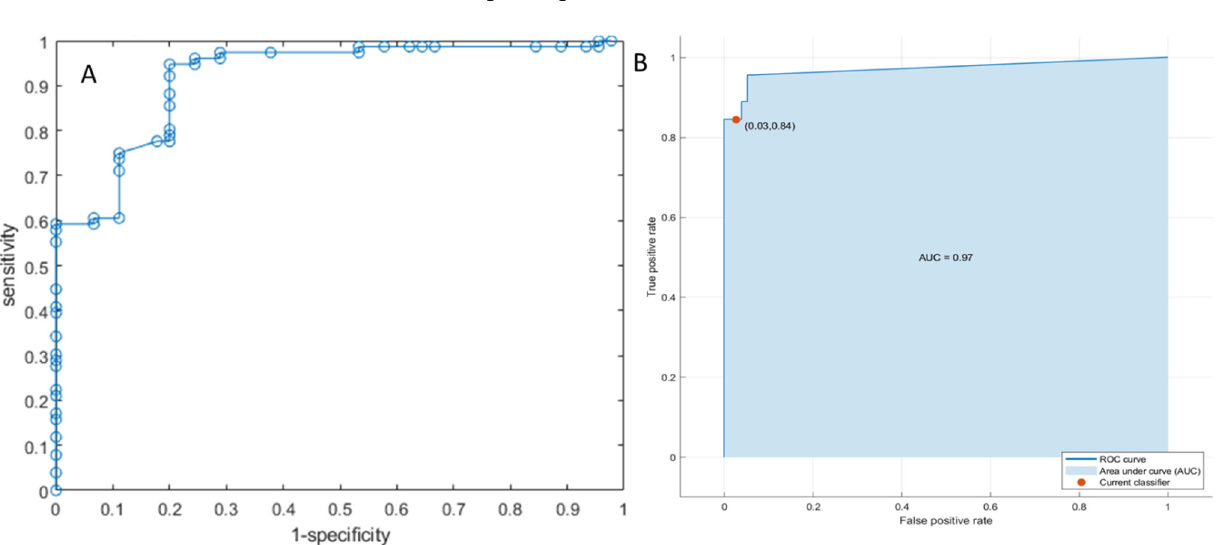
Figure 1 showed the ROC curve of linear regression model of 15 significant features by T2w sequence and the ROC curve of a KNN trained with the 9 significant predictors extracted from the portal phase.